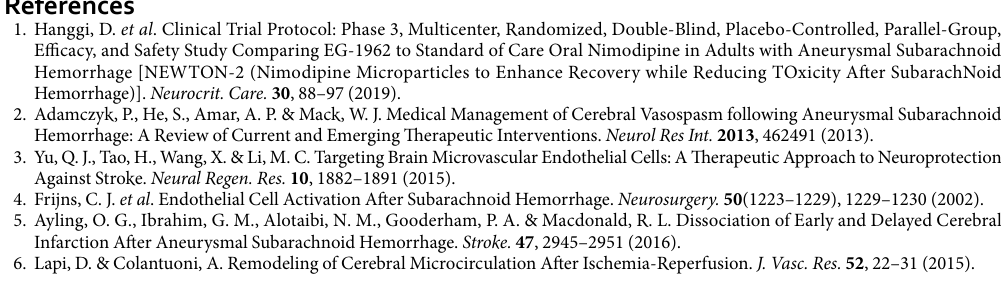
conclusions in subsequent studies. Secondly, the secretion of exosomes is affected by many external factors, which still needs to be verified by large clinical samples. In addition, exosomes contain multiple miRNAs, and their interactions remain unclear. The expression regulation of miR-630 in the content and its downstream regulatory targets are still unclear which will be investigated in our further studies. In our further studies, we will explore the role of exosomes after aSAH through RNA-Seq and proteomic differences analysis and select healthy people as the control. Finally, we only studied the relationship between CSF exosome miRNA-630 and endothelial function. It is certain that CSF exosomes can be used to study the pathological changes of cerebral microcirculation. We look forward to more research in this area.